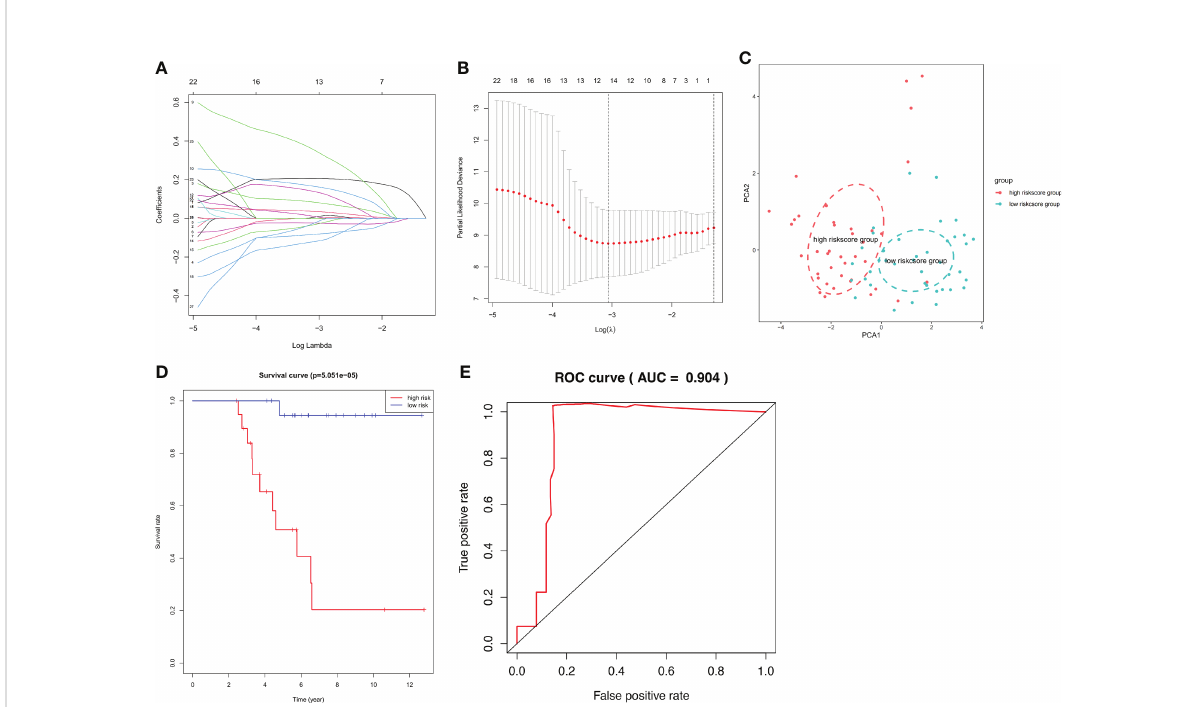
FIGURE 8 IRS RNA-expression pro fi les. (A, B) LASSO coef fi cient spectrum of the 13 selected genes from the TCGA training cohort. (C) Principal Component Analysis (PCA) strati fi cation of TCGA-ACC patients into low- and high-risk groups. (D) Kaplan – Meier curve showing that the survival rate of the low-risk group was signi fi cantly greater than the high-risk group in the TCGA training cohort. (E) ROC curve showing the predictive ef fi ciency of the risk